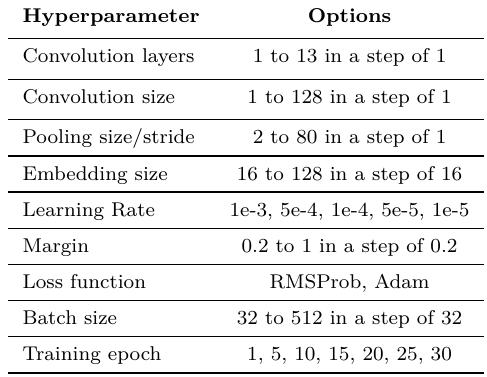
Table 1: Hyperparameters search space for the triplet network.